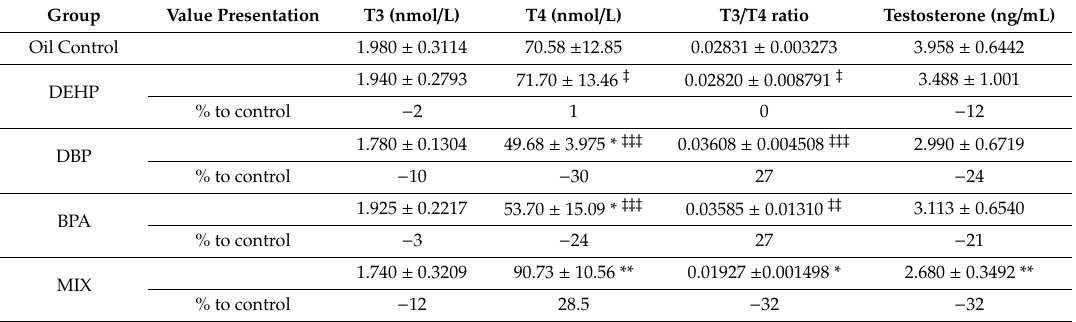
Table 7. The serum hormone level of rats orally exposed to DEHP, DBP, BPA, and their mixture (MIX) for 28